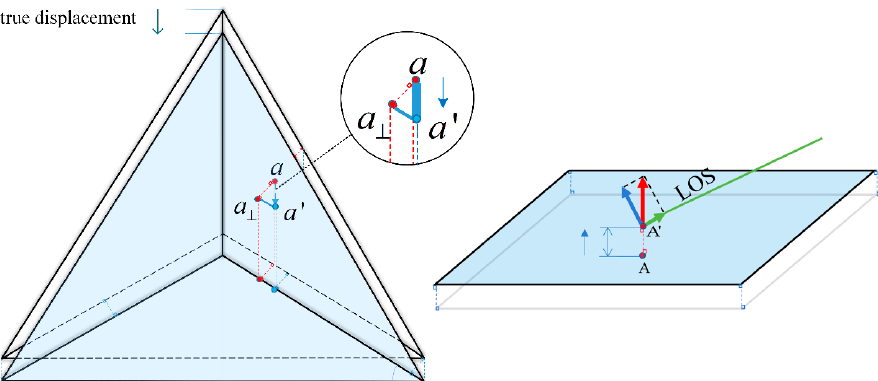
Figure 12. TLS CR1 and tiles displacement calculation. For CR1, the blue colored plane is the plane after moved. a and a ′ are on different planes, which respectively represents the gravity center of the two planes before and after moved. Right part shows tiles displacement, GB-SAR measurement is the true displacement vector (the red arrow) projected onto the LOS direction (the green arrow).